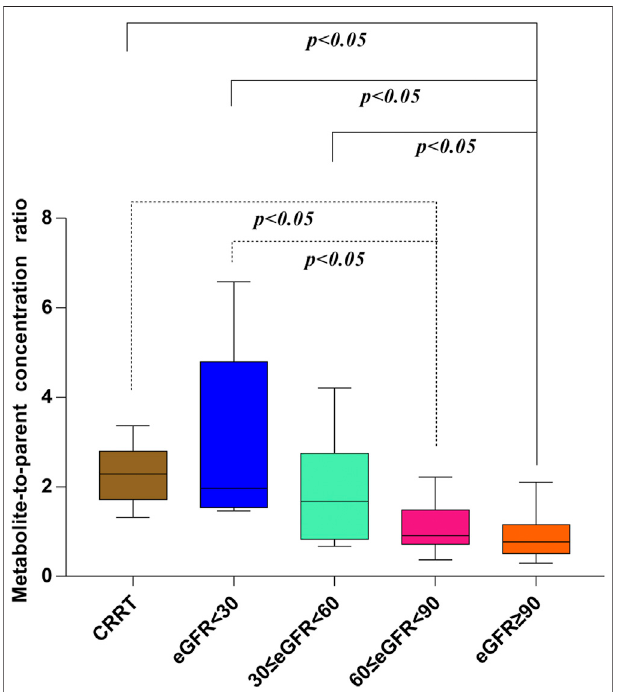
FIGURE 3 | Metabolite-to-parent concentration ratios of PNU-142300 strati fi edbyrenalfunction.TheKruskal-Wallistestwasusedforcomparisonof metabolite-to-parent concentration ratios between groups, and P < 0.05 was considered as meaningful.